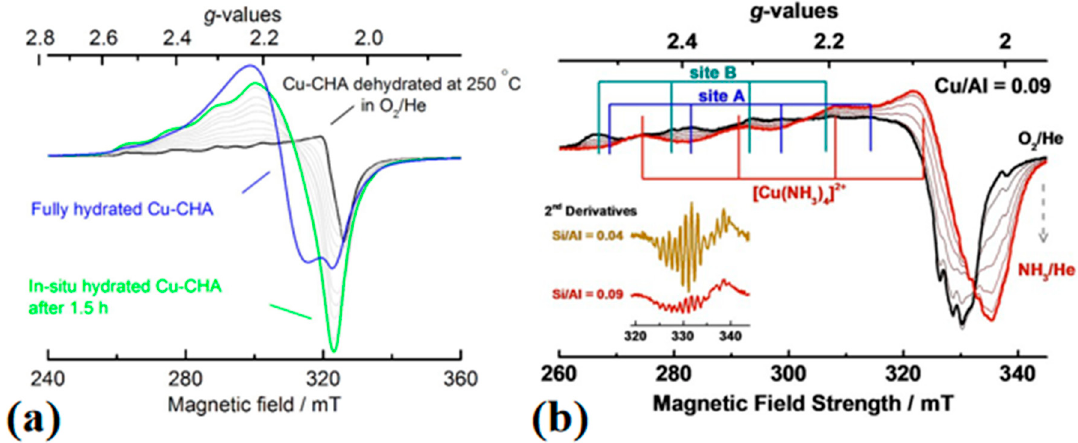
Figure 8. ( a ) In situ Electron Paramagnetic Resonance (EPR) spectra of Cu-CHA after dehydration at 250 °C in an O 2 /He flow (black line) and successive spectra during the slow exposure to trace water at room temperature: the anisotropic spectrum after 1.5 h is outlined in green, and the final spectrum after exposure to moist ambient conditions without flow for several days is shown in blue. Reproduced with permission from [99], copyright American Chemical Society, 2014. ( b ) In situ EPR spectra of the reaction of dehydrated Cu/Al = 0.09 with 1000 ppm NH 3 at 100 °C: thin lines are intermediate spectra spaced by 45 s. Reproduced with permission from [101], copyright Wiley-VCH, 2018.